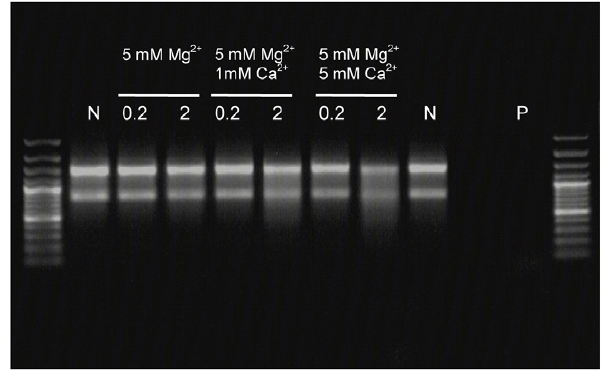
Figure 5. Examination of RNase activity in the shrimp nuclease preparation. Total RNA was incubated with 0.2 or 2 units of enzyme in the presence of only MgCl 2 or of MgCl 2 + CaCl 2 . Negative control (N: no enzyme), positive control (P: commercial RNase A).